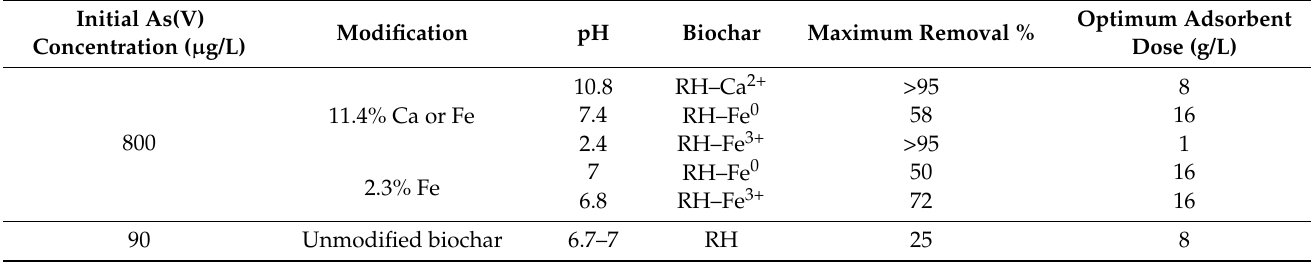
Optimum Adsorbent Dose (g/L)